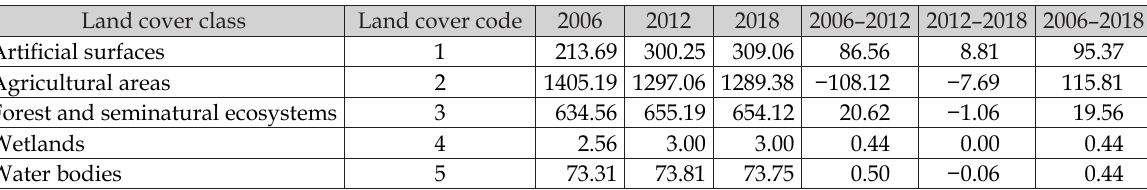
Table 3. Statistics of land cover changes in km 2